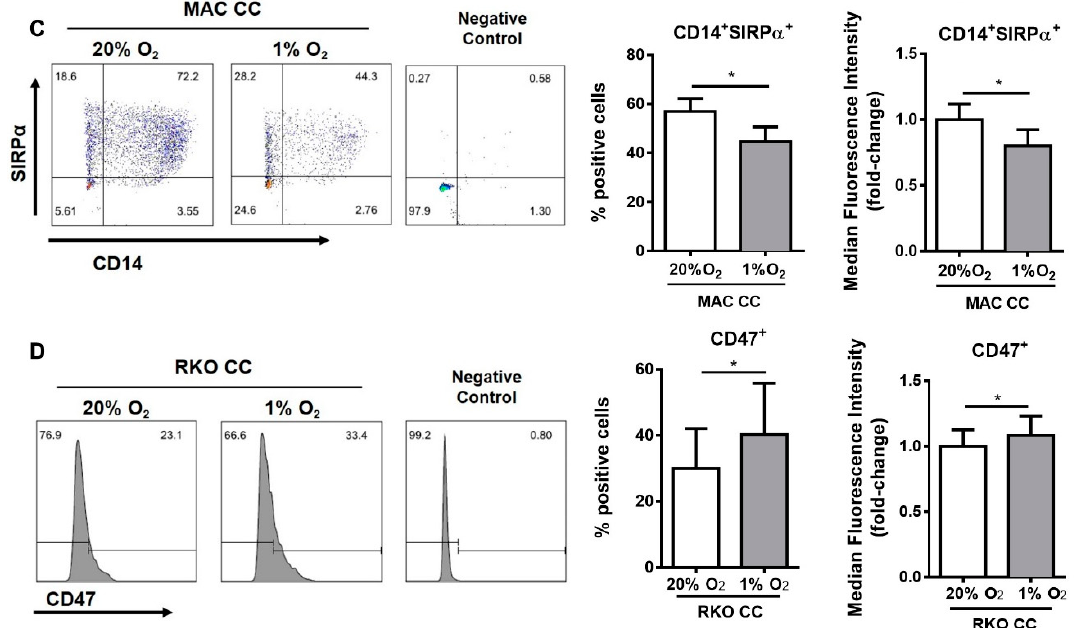
Figure 3. Hypoxia modulates macrophage phagocytic activity and SIRP α expression and CD47 expression on cancer cells. ( A , B ) Macrophages that were indirectly co-cultured with RKO (MAC CC) cells, at 20% or 1% O 2 for 72 h, were posteriorly directly stimulated with CFSE-labeled RKO cells for 2 h. Macrophages were analyzed by flow cytometry. Histograms display the gating strategy for flow cytometry created with FlowJo. ( A ) Phagocytic activity was calculated as the ratio of CD14+CFSE+ cells/Total CD14+ cells. ( B ) Graphs represent the percentage of CD14+CFSE+SIRP α + cells, and the median fluorescence intensity, which is presented as fold-change relatively to 20% O 2 condition. ( C , D ) Macrophages were indirectly co-cultured with RKO, at 20% or 1% O 2 for 72 h. Expression of the monocyte/macrophage lineage marker CD14 and SIRP α was evaluated on macrophages ( C ) and of CD47 on cancer cells ( D ) by flow cytometry. Pseudo-color plots ( C ) and histograms ( D ) display the gating strategy for flow cytometry. Graphs represent the percentage and median fluorescence intensity, which is presented as fold-change relatively to 20% O 2 condition of ( C ) CD14+SIRP α +, or ( D ) CD47 cells. Graphs represent the mean values with standard deviations, and are representative of n = 11 (phagocytosis); n = 7 (CFSE+SIRP α +); n = 10 (SIRP α ); n = 11 (CD47) independent experiments. The statistical tests Wilcox or paired t -test were used; * p < 0.05.